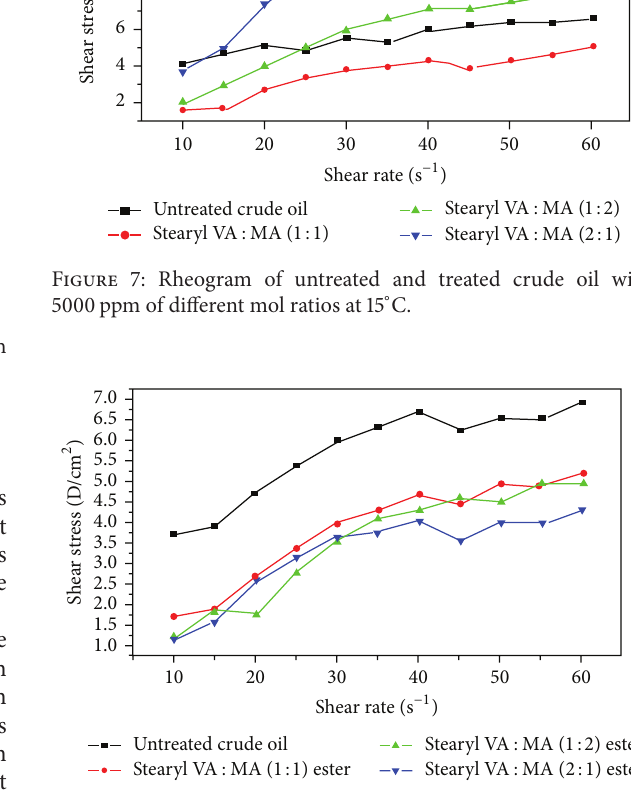
Figure 8: Rheogram of untreated and treated crude oil with 5000 ppm of different mol ratios at 21 ∘